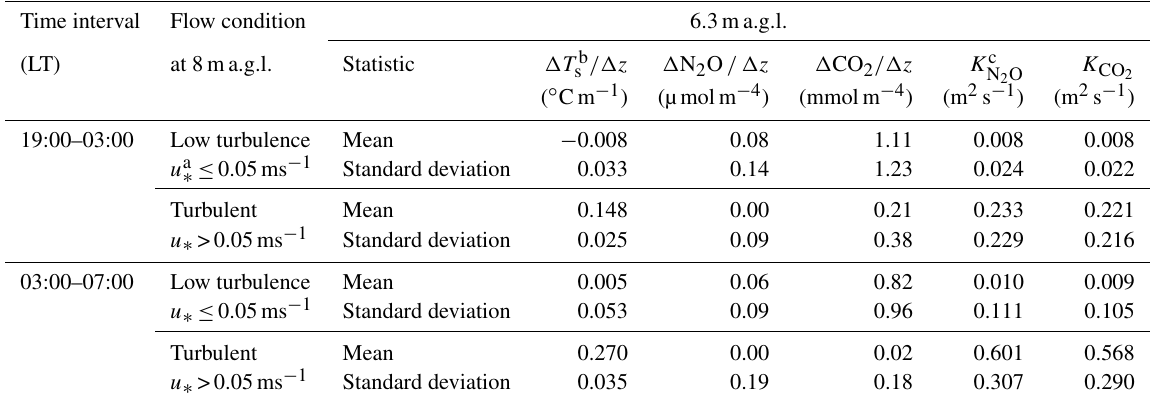
Table 3. Characteristics of the nocturnal boundary layer at the top of the accumulation control volume with stable conditions (positive local Obukhov length) at 8m. Statistics based on 30min averaging periods. Time